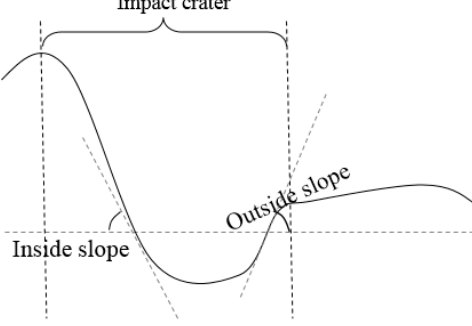
Figure 7. Schematic description for some of the indices in Table 3.